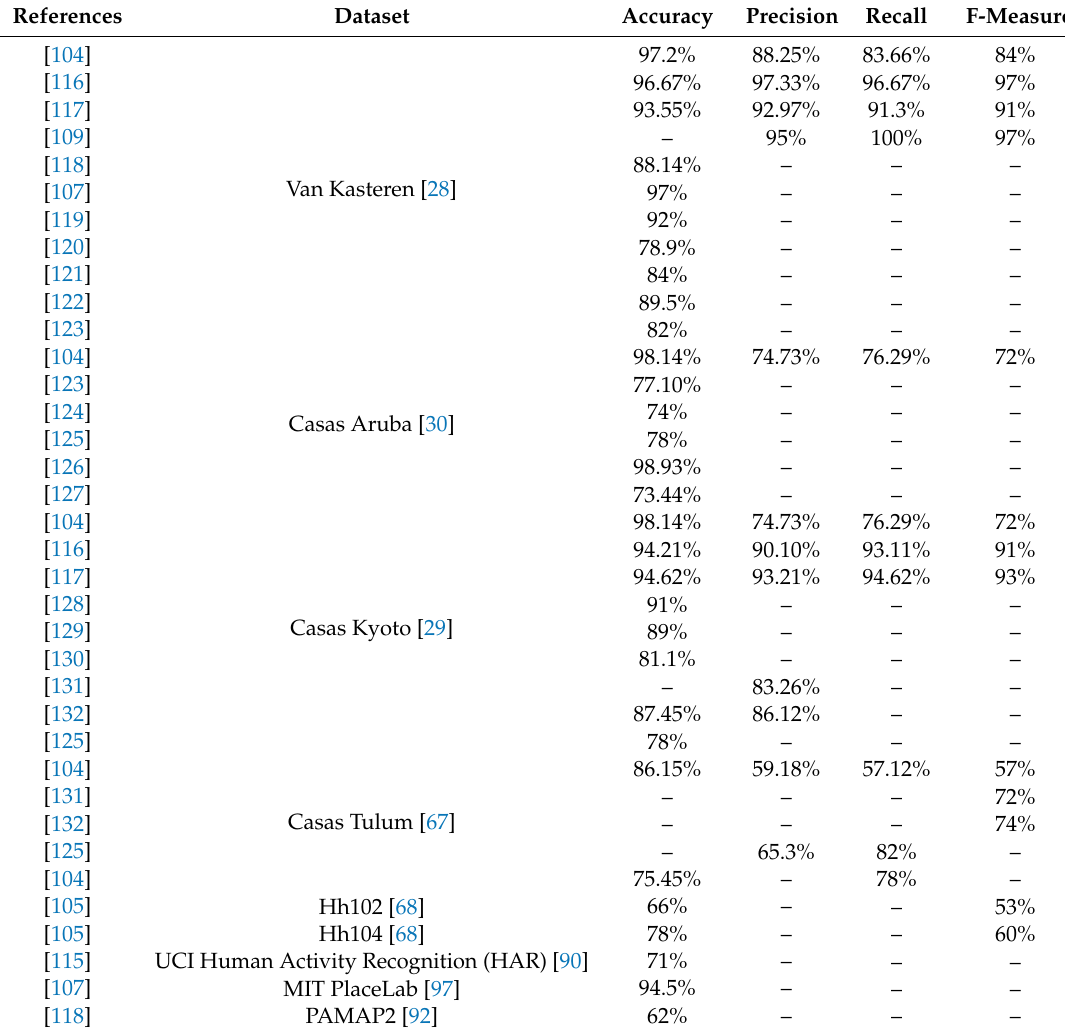
Table 8. Details of the K-NN